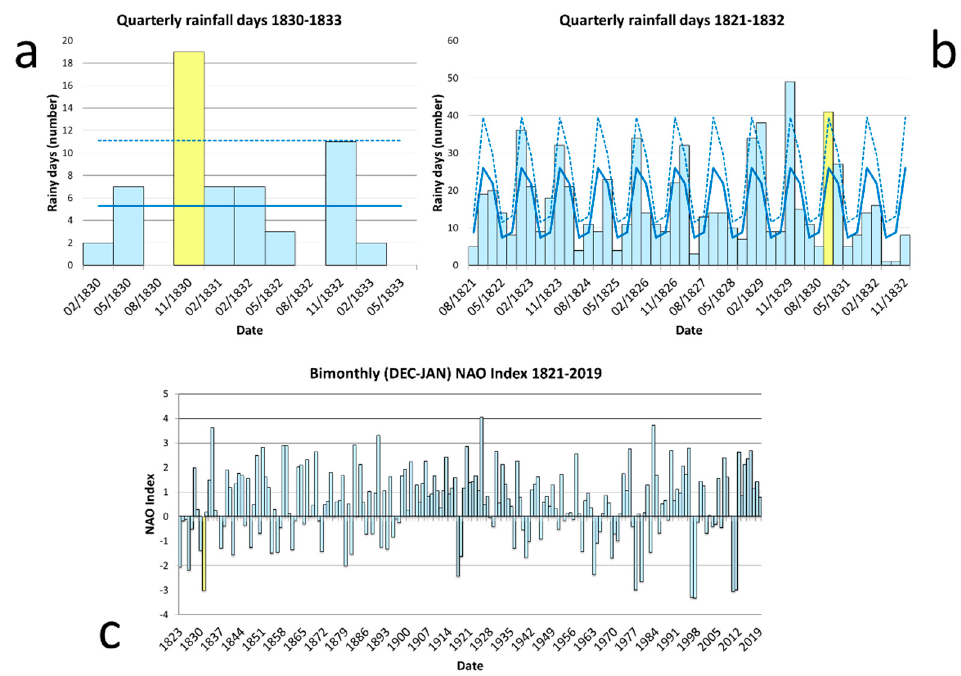
Figure 3. ( a ) Quarterly rainfall days 1830–1833 in Badajoz; ( b ) quarterly rainfall days 1821–1832 in Gibraltar. The dotted line represents mean + standard deviation of the values, and the solid line below, the mean; ( c ) bimonthly (DEC-JAN) North Atlantic Oscillation (NAO) index 1821–2019. Values observed during the reported event are highlighted in yellow.